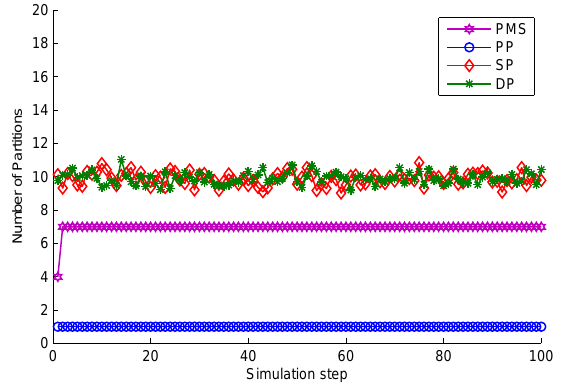
Figure 10. The comparison of four approaches in OSPA distance.